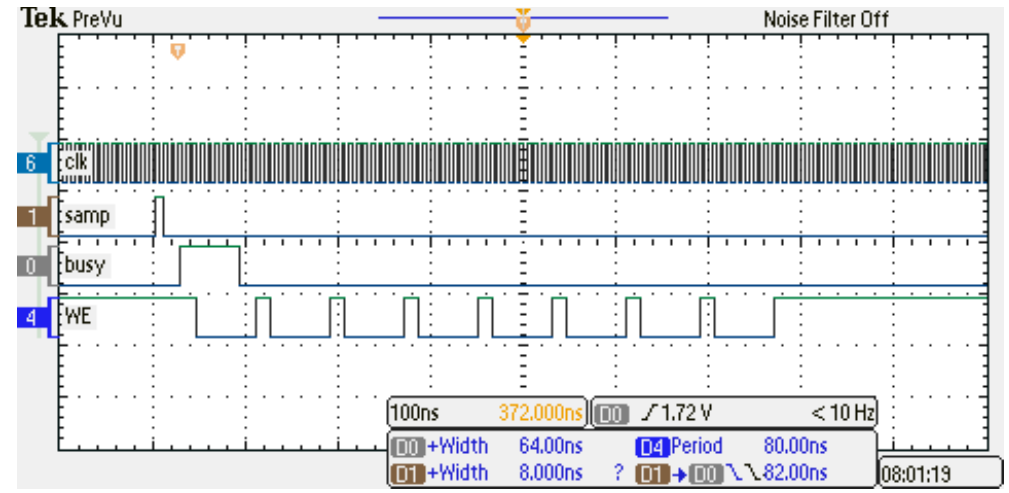
Figure 8. The timing diagram of the core FPGA circuit.